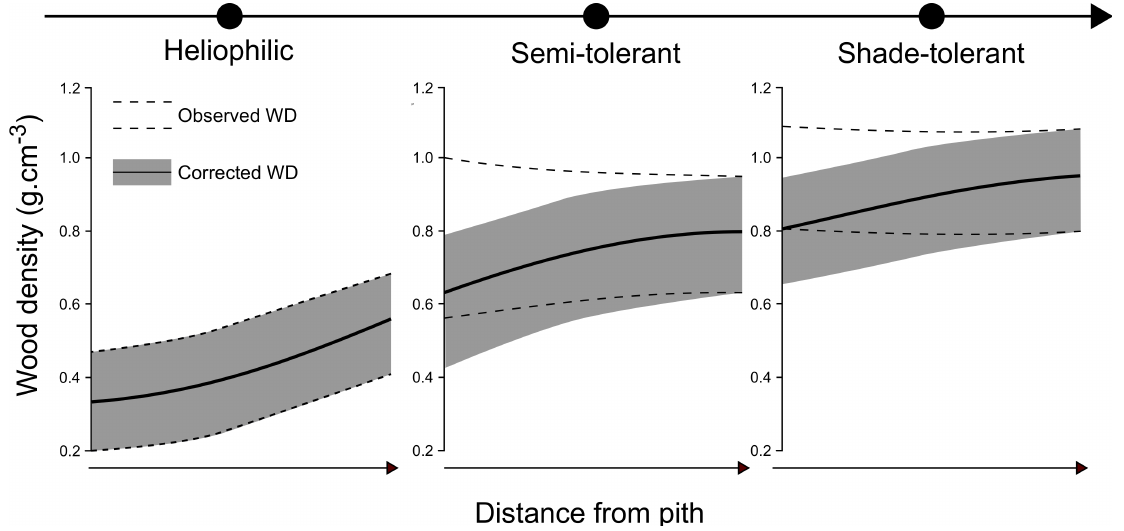
Figure 6. Change in observed and corrected WD radial pattern along the shade-tolerance continuum. Dashed lines indicate the observed WD range, gray band and solid line indicate the corrected WD range and the median trajectory, respectively. Note that for heliophilic species, the corrected and observed range are equal as the heliophilic species sampled are